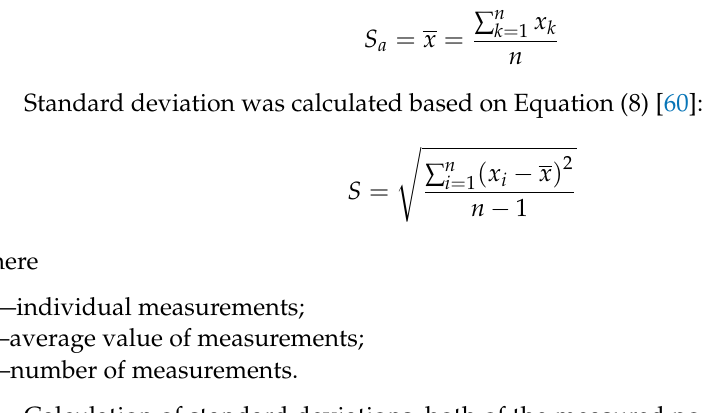
Table 3. Calculation of average deviations.